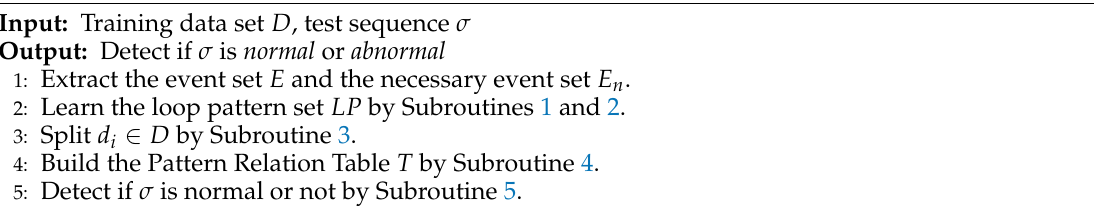
Algorithm 1 Centralized Pattern Relation Table